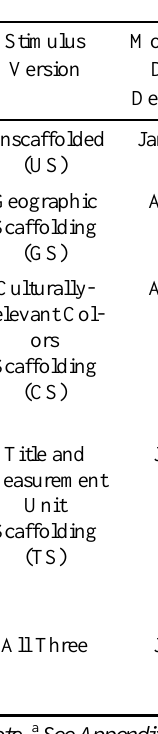
Scaffolding types per stimulus visualization